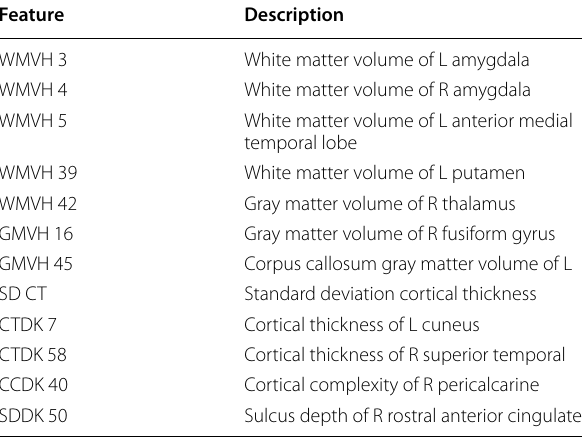
Table 4 Selected features by the FCBF algorithm Feature